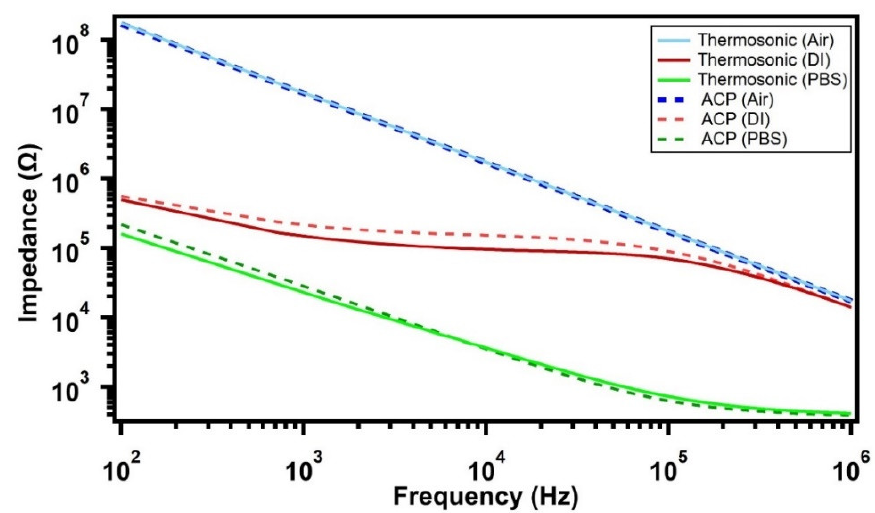
Figure 6. Impedance analysis of the ACP- and thermosonic-bonded samples in 3 mediums (air, Di water and PBS). The results revealed similar behavior up to 1 MHz.